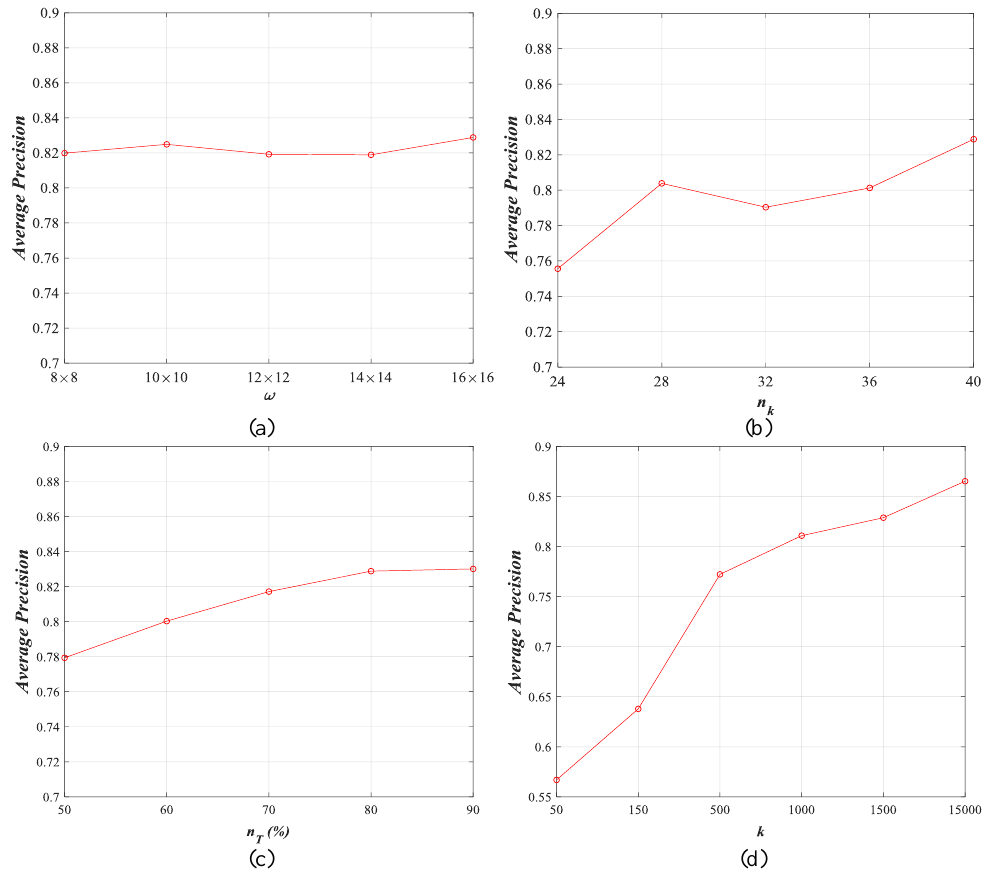
Figure 23. Influence of different parameters for ImgDB1. ( a ) ω ; ( b ) n k ; ( c ) n T ; ( d ) k